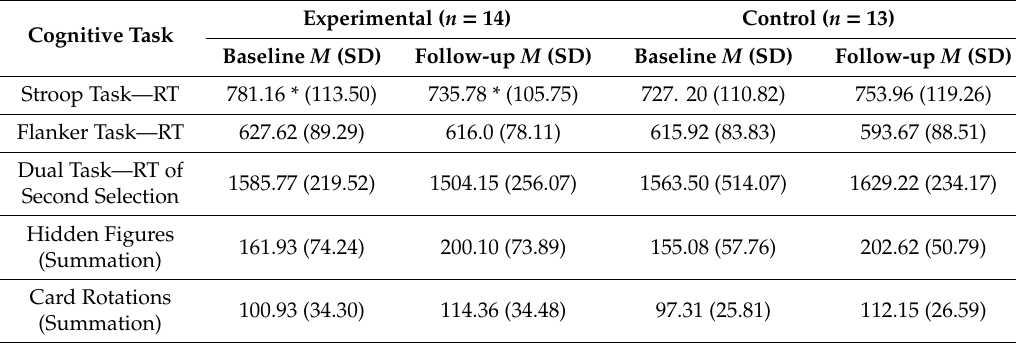
Table 3. Cognitive outcome measures by